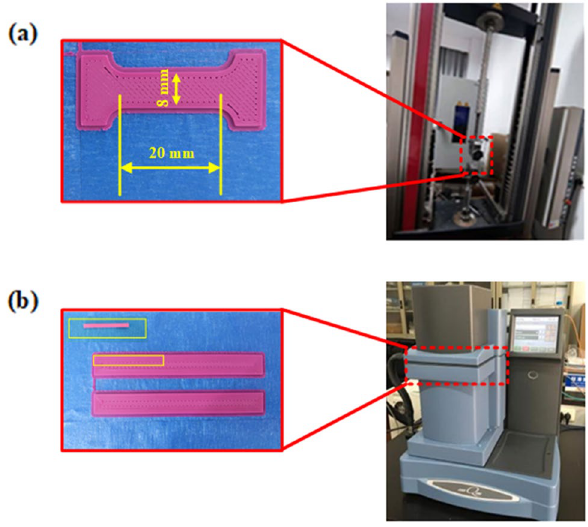
Figure 1. ( a ) DMA machine and printed sample; ( b ) tensile machine and printed